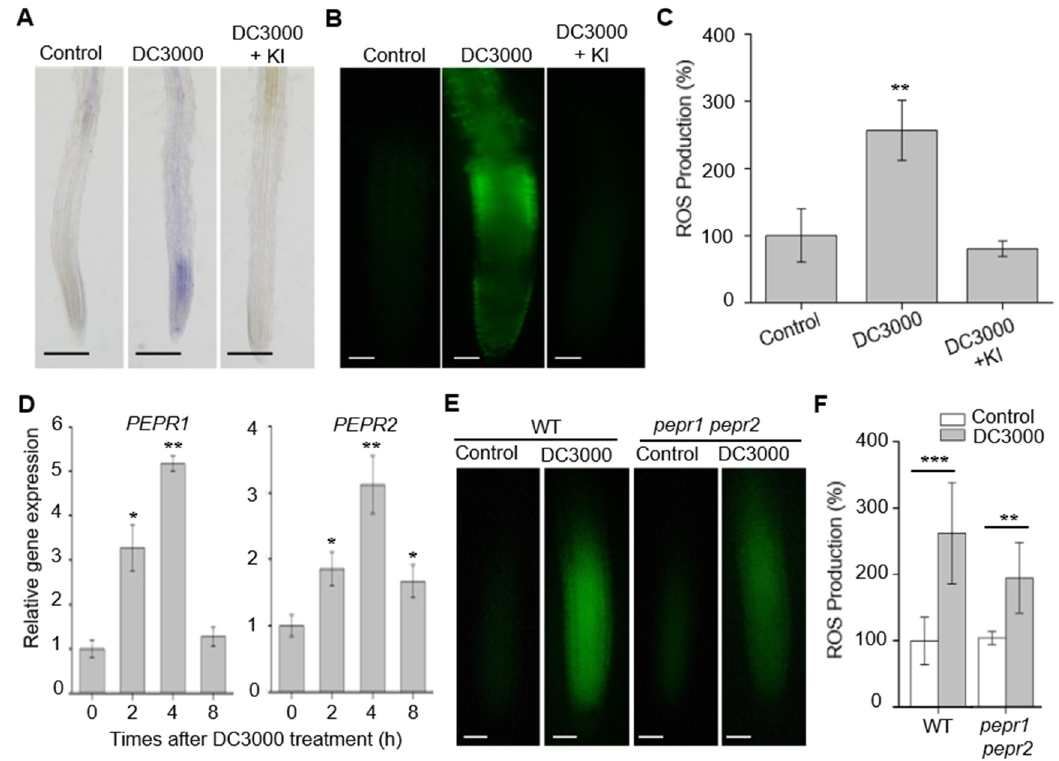
Figure 1. PEPRs are required to regulate the root immunity. ( A ) NBT staining of superoxide (O 2 − ) anion in wild type (WT) roots. Six-day-old seedlings were incubated in half-strength Murashige and Skoog (MS) liquid medium (Control), Pst DC3000 (DC3000) solution (initial OD 600 of 0.02), or DC3000 solution (initial OD 600 of 0.02) and added to 100 µ M KI for 18 h. The roots were stained with 1 mM NBT solution for 60 min and photographed under microscopy. Bars = 200 µ m. ( B ) H 2 DCF-DA staining of H 2 O 2 in WT roots. Six-day-old seedlings were incubated in half-strength MS liquid medium (Control), DC3000 solution (initial OD 600 of 0.02), or DC3000 solution (initial OD 600 of 0.02) and added to 100 µ M KI for 18 h. The roots were stained with 30 µ M H 2 DCF-DA solution for 10 min and photographed under fluorescence microscopy (Olympus, BX53). Bars = 100 µ m. ( C ) The statistical analysis of ROS production in ( B ). The relative ROS production of each treatment was normalized to control the wild type (100%). Data are means ± SD from three independent experiments ( n = 20). ( D ) Quantitative RT-PCR analysis of mRNA levels of PEPR1 and PEPR2 in the wild type roots, treated with DC3000 solution (initial OD 600 of 0.02) for 0, 2, 4, and 8 h, respectively. The expression level of control (0 h) was set as 1.0 and the DC3000 treatment levels were normalized to the control level. Data are means ± SD ( n = 3). ( E ) H 2 DCF-DA staining of H 2 O 2 in WT and pepr1 pepr2 roots. Six-day-old seedlings were incubated in half-strength MS liquid medium (control) and DC3000 solution (initial OD 600 of 0.02) for 18 h. The roots were stained with 30 µ M H 2 DCF-DA solution for 10 min and photographed under fluorescence microscopy (Olympus, BX53). Bars = 100 µ m. ( F ) The statistical analysis of ROS production in ( E ). The relative ROS production of each treatment was normalized to control the wild type (100%). Data are means ± SD from three independent experiments ( n = 24). Asterisks in ( C ), ( D ), and ( F ) indicate statistically significant differences compared with the controls in each genotype (Tukey’s test, * p < 0.05, ** p < 0.01, *** p < 0.001).